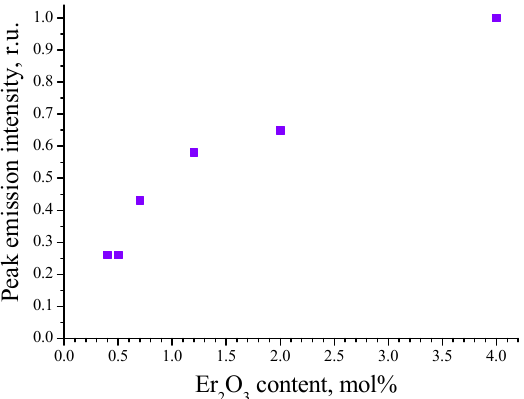
Figure 10. The 2.75 µm luminescence peak intensity versus Er 2 O 3 content. The lifetimes of the 4 I 11/2 level of Er 3+ were measured by registration of the 0.98 µm emission, the decay curves for glasses of the TWBL-xEr are plotted in Figure 11. The measured lifetimes of the 4 I 11 / 2 level of Er 3+ ion were 113, 113, and 104 µ s for the Er 2 O 3 contents of 0.4, 1.2, and 4 mol%, respectively. The 4 I 13/2 Er level lifetimes were measured by registering the 1.53 µ m emission. The measured lifetimes of the 4 I 13 / 2 level of Er 3+ ion were 7.0 and 6.5 ms for the Er 2 O 3 contents of 0.4 and 4 mol%, respectively. An exponential attenuation of the luminescence intensity was observed when the excitation is removed, presumably the excited ions interact weakly with neighboring ions in the ground state. For both 4 I 11/2 and 4 I 13/2 energy levels, a 10-fold increase in concentration led to a de- crease in the lifetime by only 10%, due to non-radiative effects from concentration quench- ing. A slow reduction in the luminescence lifetimes, with a large increase in the Er 3+ con- centration, indicates weak concentration quenching. The possibility of creating high con- centrations of dopant in the glass and weak concentration quenching confirms the absence of Er 3+ ion clustering in the glasses [25].